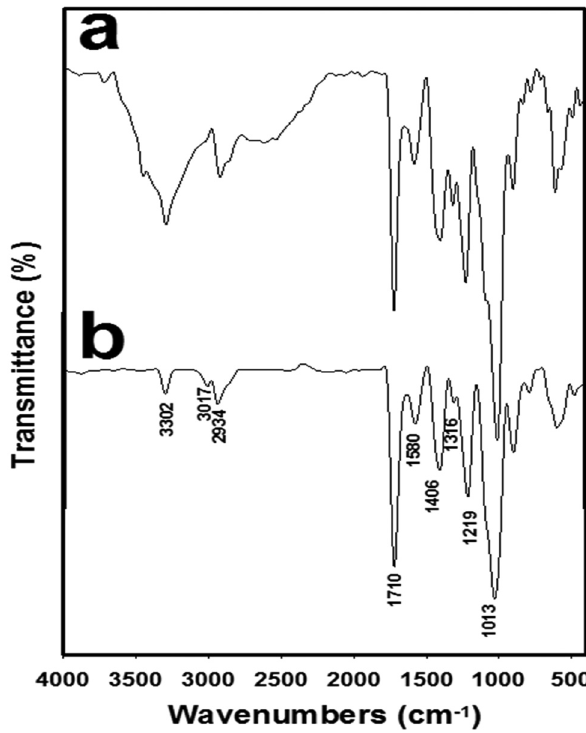
Figure 3: FTIR spectra of ( a ) ( PVP:CMC ) /CA/G fi lm and ( b ) ( PVP:CMC ) /CA/G – ZnO nano fi